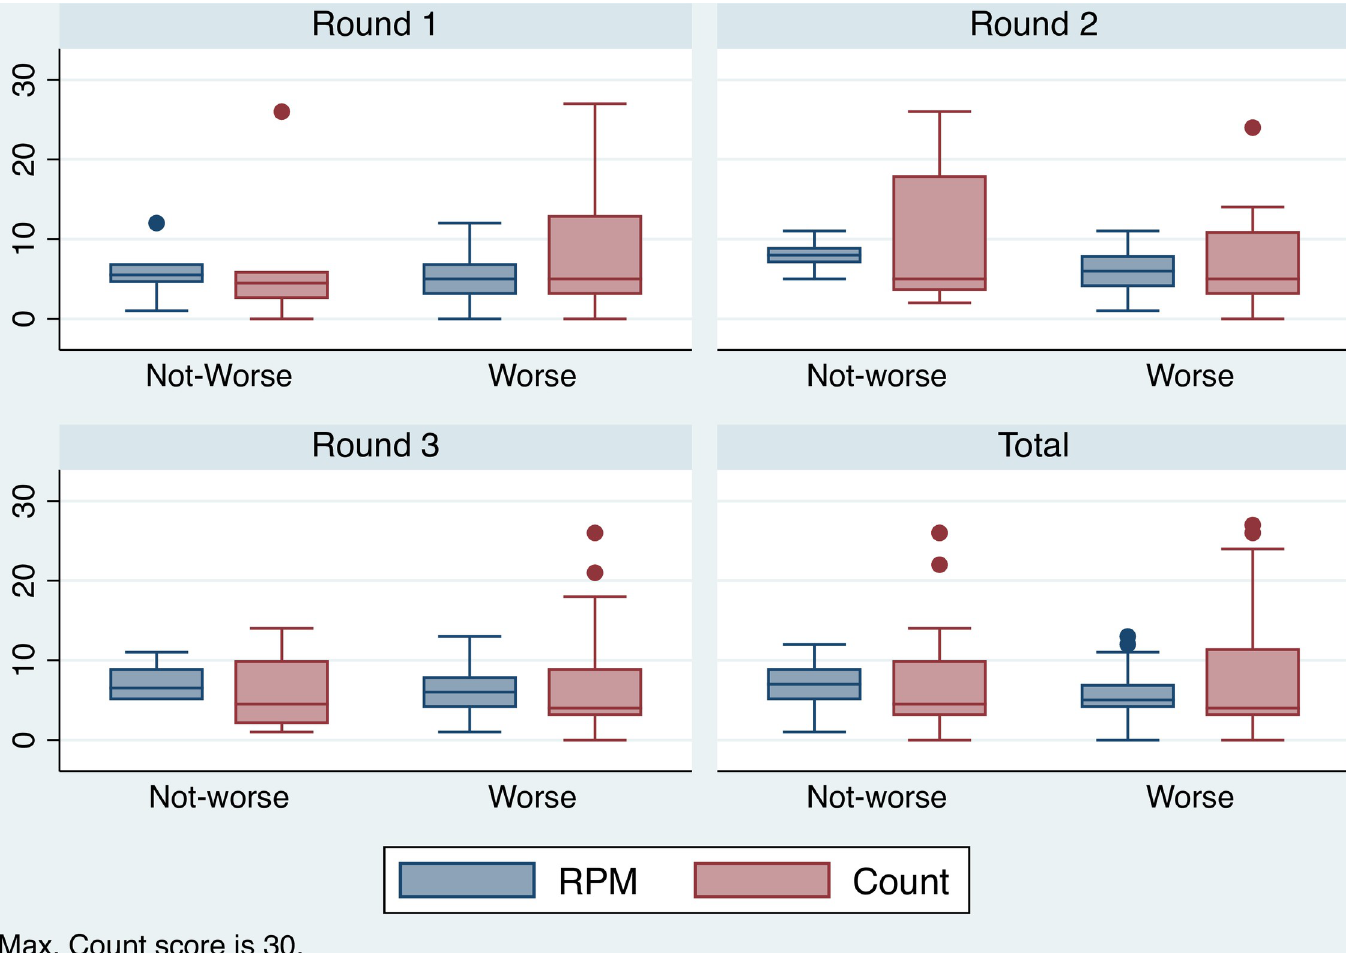
Fig 5. Distribution of RPM and Count by perception of past income. Boxplot showing the relationship between RPM, Count and perception of past income (1 = worse than expected) across three survey rounds (Count max.30).